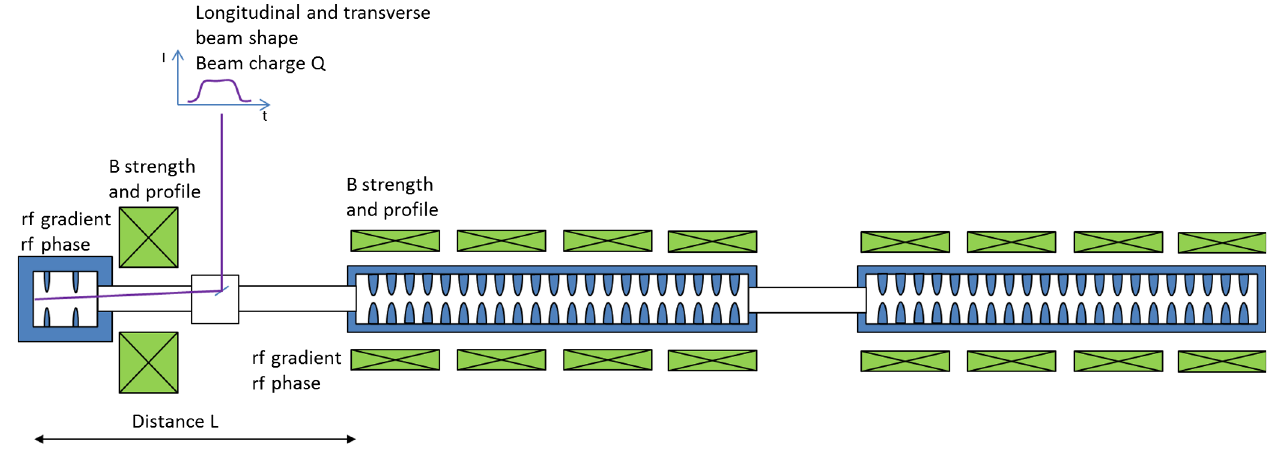
FIG. 1. Schematic layout of a photoinjector.